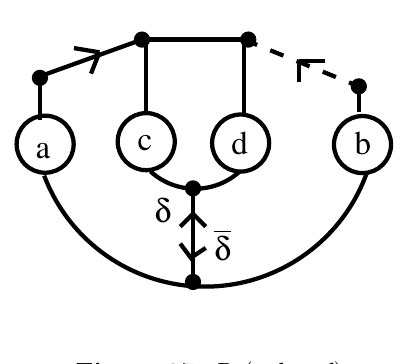
Figure 27 . R 1 ( a; b ; c; d